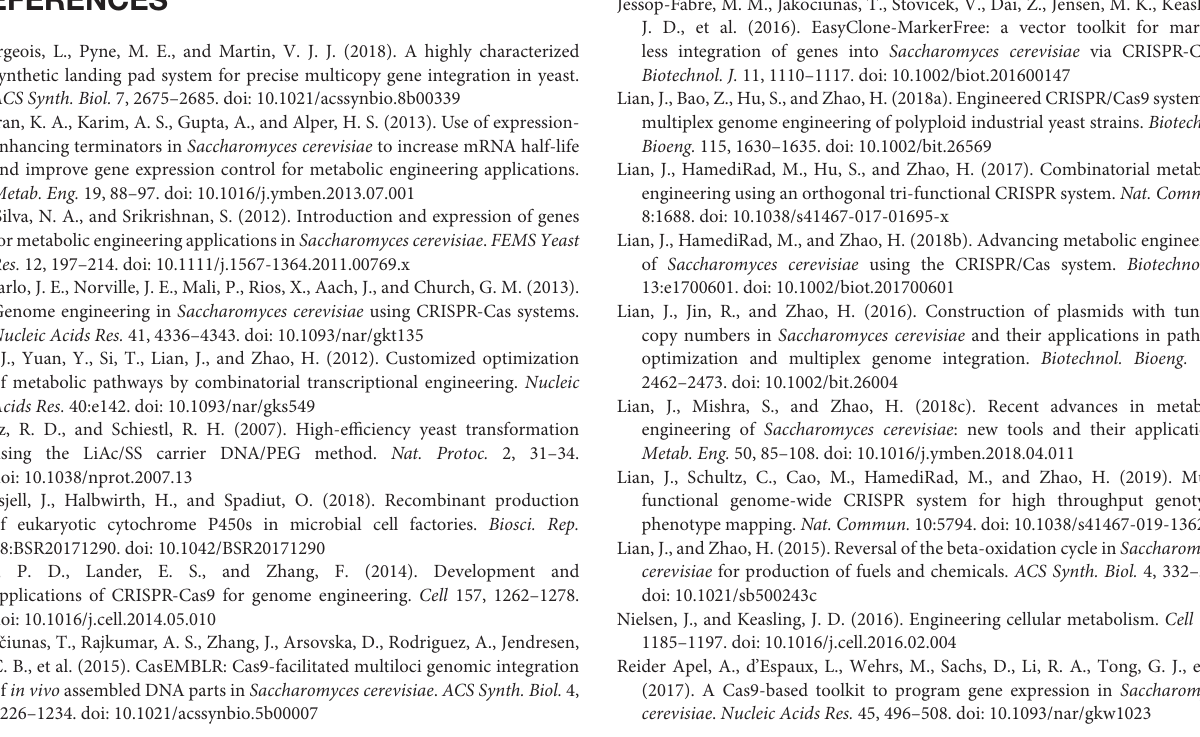
Supplementary Table 5 . Oligos used to construct gRNAs were listed in Supplementary Table 6